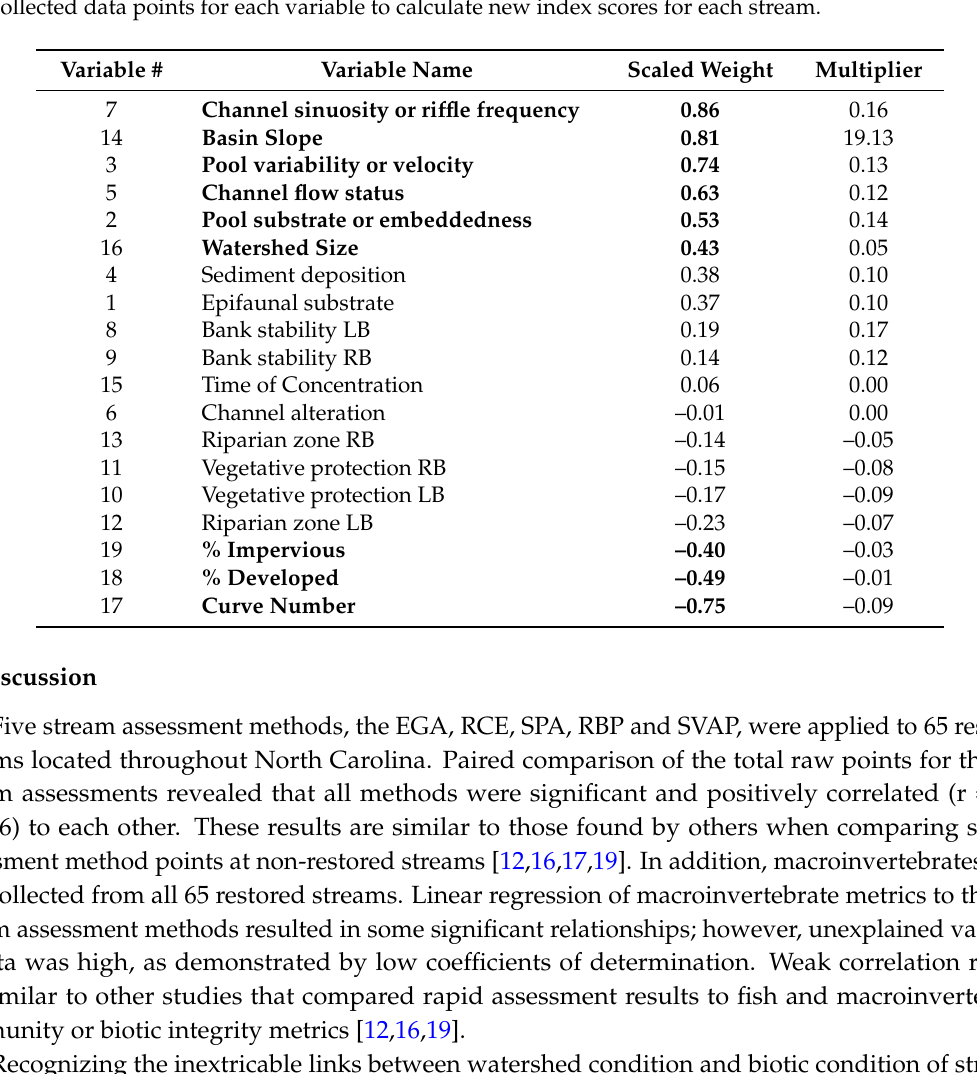
Table 9. RBP Index (including watershed factors) scaled and un-scaled (multiplier) weights. Variables with larger scaled weights (absolute value ě 0.4) are shown in bold. Scaled weight indicates the relative importance of each variable for prediction of EPT taxa. The multiplier can be used with the field collected data points for each variable to calculate new index scores for each